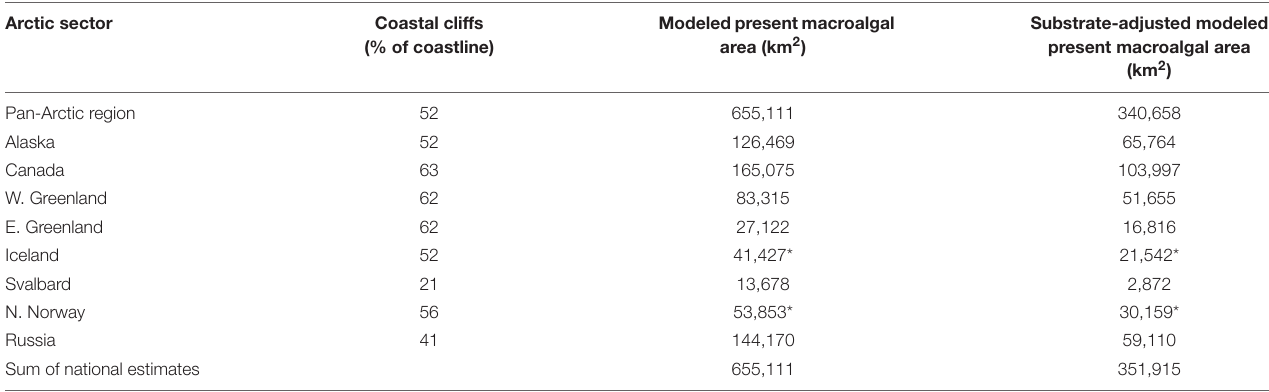
TABLE 4 | Information on substrate conditions for Arctic coastlines and potential total distribution area of brown macroalgae, and distribution areas adjusted by substrate conditions. Arctic sector Coastal cliffs